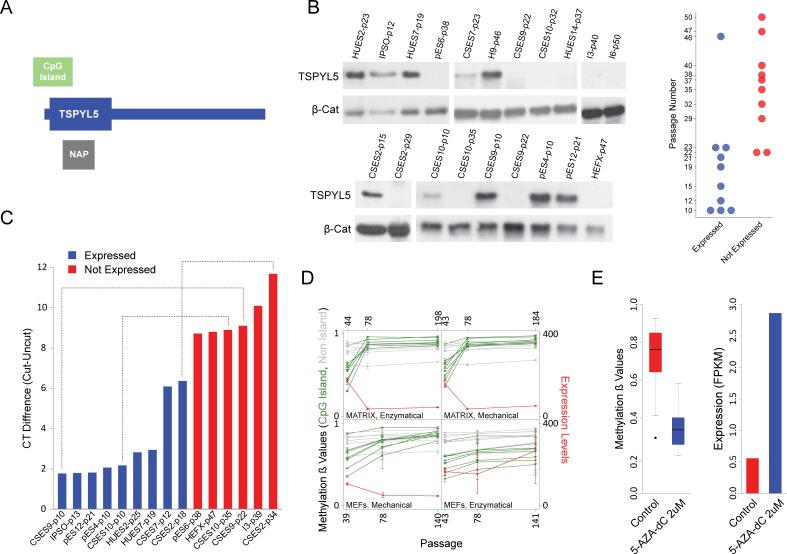
TSPYL5 undergoes hyper methylation and silencing in culture.(A) Schematic representation of TSPYL5 gene. (B) Western blot analysis for TSPYL5 of samples from multiple hPSCs cell lines at different passages. The plot at the right panel represents the TSPYL5 expression state of each sample as detected in the western blot analysis. (C) Analysis of methylation levels using the methylation sensitive enzyme McrBC. Shown are differences between quantitative-PCR (qPCR) results of digested and undigested DNA. Blue samples express TSPYL5 while red samples do not. Samples of the same cell line are connected with dashed line. (D)
TSPYL5 expression and methylation changes during continuous passaging of the WA09 cell line. Samples were grown either on extracellular matrix or on MEFs, and passaged mechanically or enzymatically. (E) Changes in TSPYL5 Expression and methylation levels in pES6 cells after 5 days treatment with 5-AZA-dC.